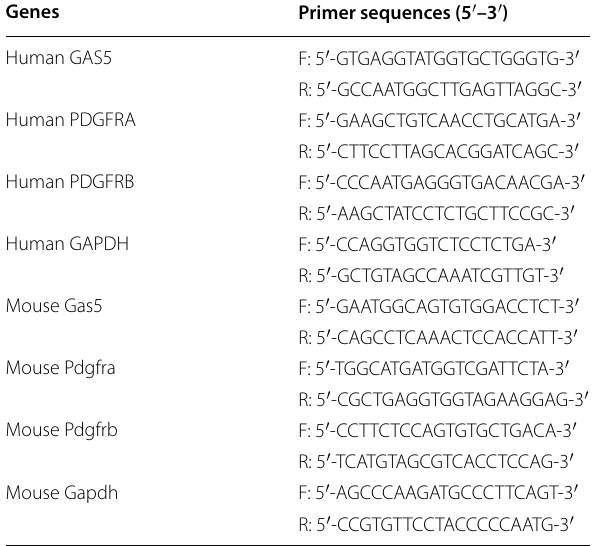
Table 3 Primers used for RT-qPCR analysis Genes Primer sequences (5 ′ –3 ′ )